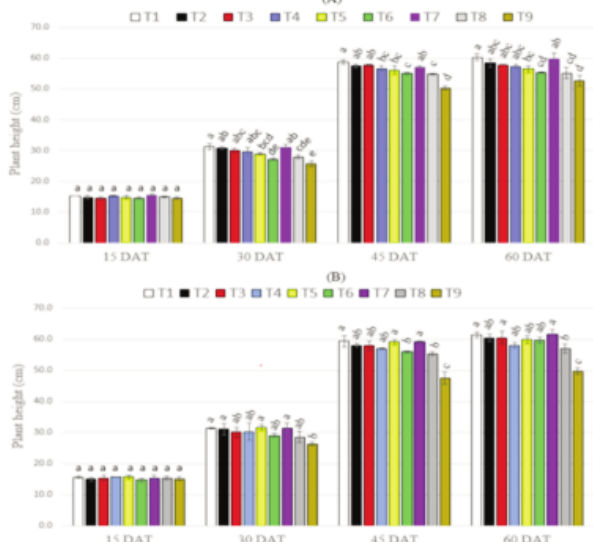
Fig. 1 ­ Plant height of tomato cv. Roma under different treat­ ments against Tuta absoluta in trials one (A) and two (B). T1: Steinernema sp. RW14­M­C2a­3, T2: Steinernema sp. RW14­M­C2b­1, T3: Metatech®WP ( Metarhizium aniso‐ pliae , Strain FCM Ar 23B3), T4: Beauvitech® WP ( Beauveria bassiana , Strain J25), T5: Tephrosia vogelii , T6: Phytolacca dodecandra , T7: azadirachtin 0.03% EC, T8: imidacloprid, T9: Water; DAT: Days after transplan­ ting; Different letters above the bars indicate significant difference according to Tukey’s test